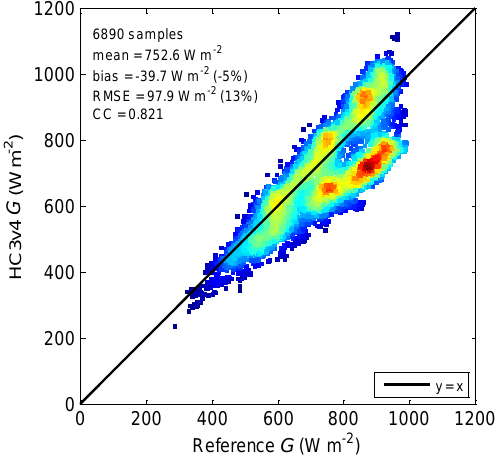
Figure 4. Scatter density plot between measurements of GHI and HC3v4 estimates under cloud-free conditions at